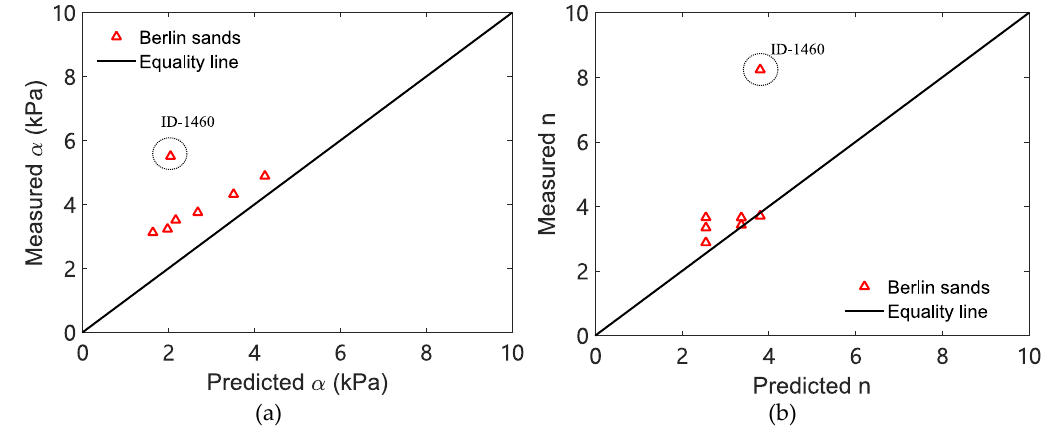
Figure 8. Comparison between predicted and measured parameters for Berlin sands. ( a ) parameter 𝛼 ; ( b ) parameter 𝑛 .